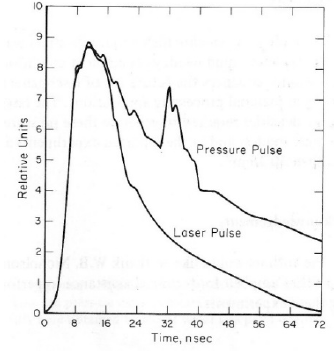
Figure 4. Comparison of laser and pressure pulse profile for the same shot measured for aluminum vapor deposited on a quartz gauge with water overlay, 1.2 × 10 9 W/cm 2 [20].